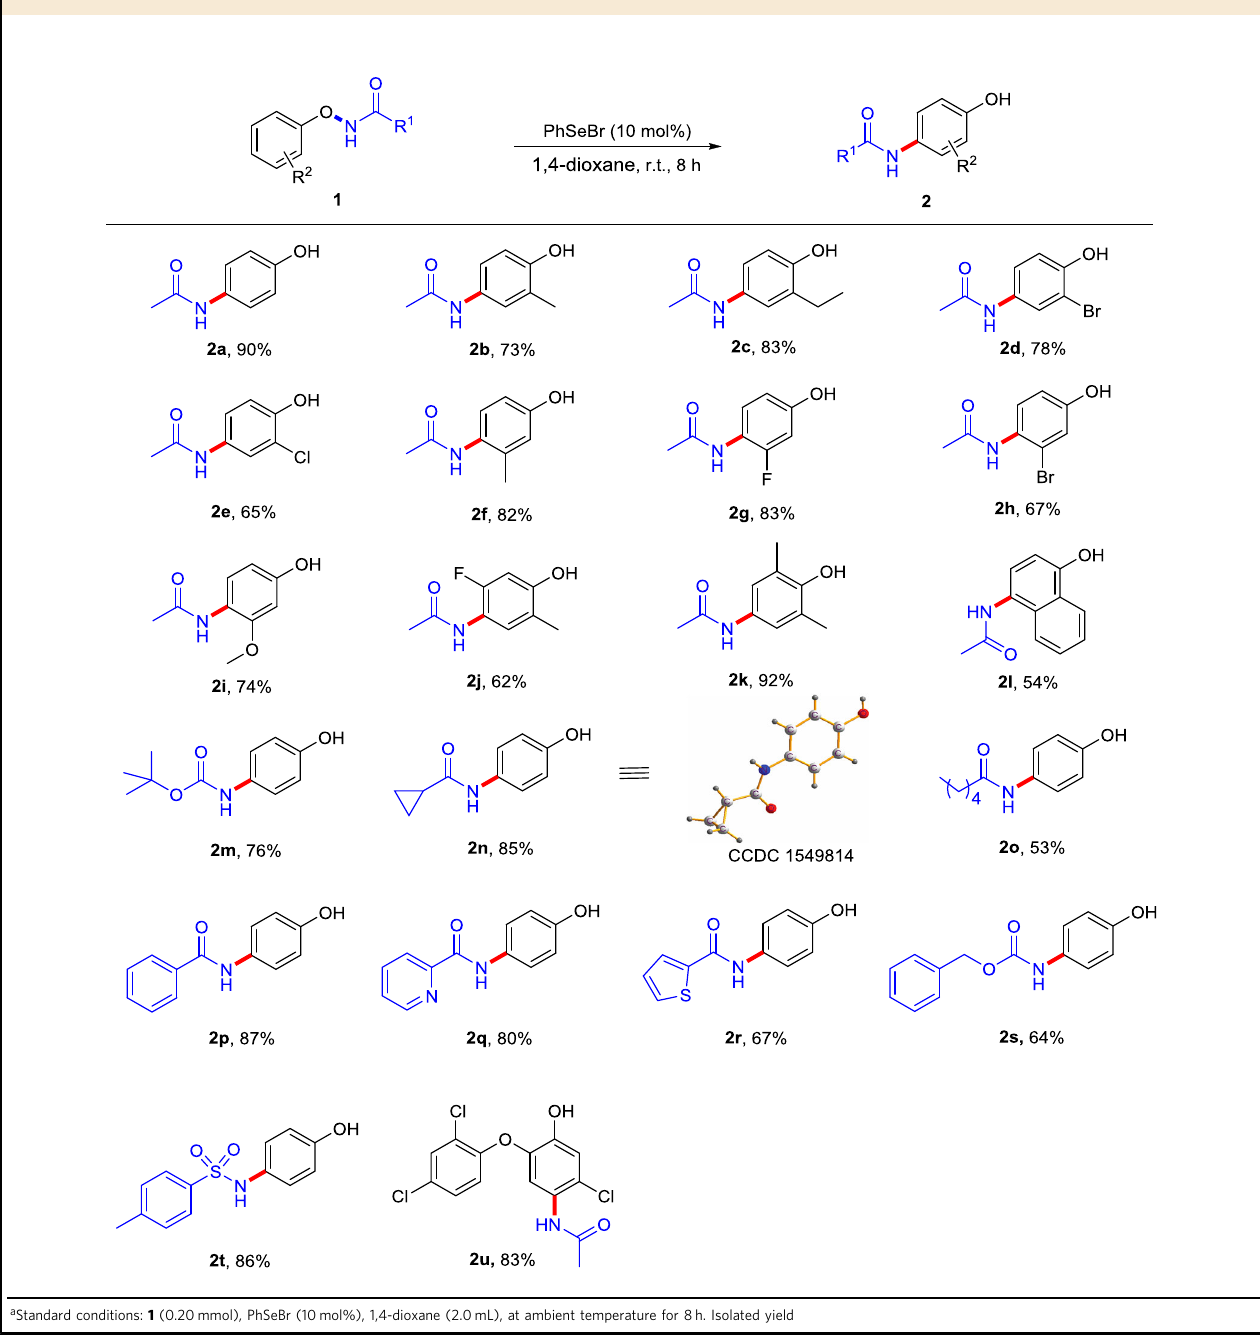
Table 1 Substrate scope of Se-catalysed para -amination of phenols